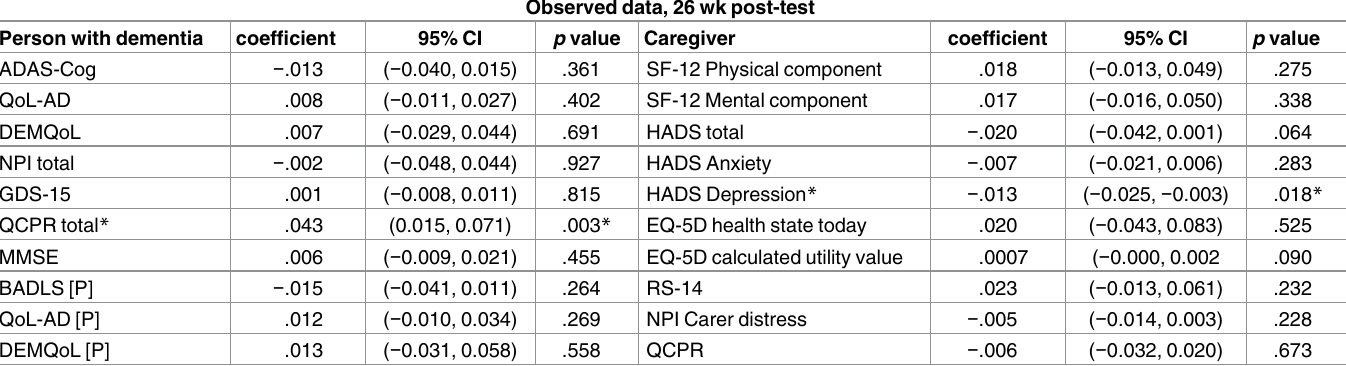
Table 4. Regression of outcome measuresat 26-wk post-test on the number of sessions of iCST attended, adjusting for BL outcome measures, marital status, centre, age, and anticholinesteraseinhibitors. Observed data, 26 wk post-test Person with